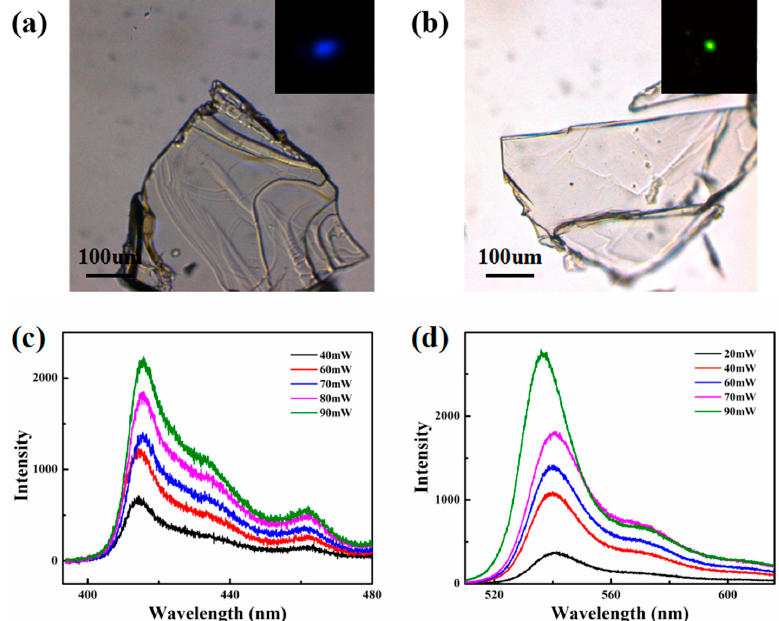
Figure 7. The bright field and dark field optical microscope images of the perovskites ( a ) (C 6 H 5 CH 2 NH 3 ) 2 PbBr 4 ; ( b ) (C 6 H 5 CH 2 NH 3 ) 2 PbI 4 ; the two-photon PL spectrum of the perovskites ( c ) (C 6 H 5 CH 2 NH 3 ) 2 PbBr 4 ; ( d ) (C 6 H 5 CH 2 NH 3 ) 2 PbI 4 .